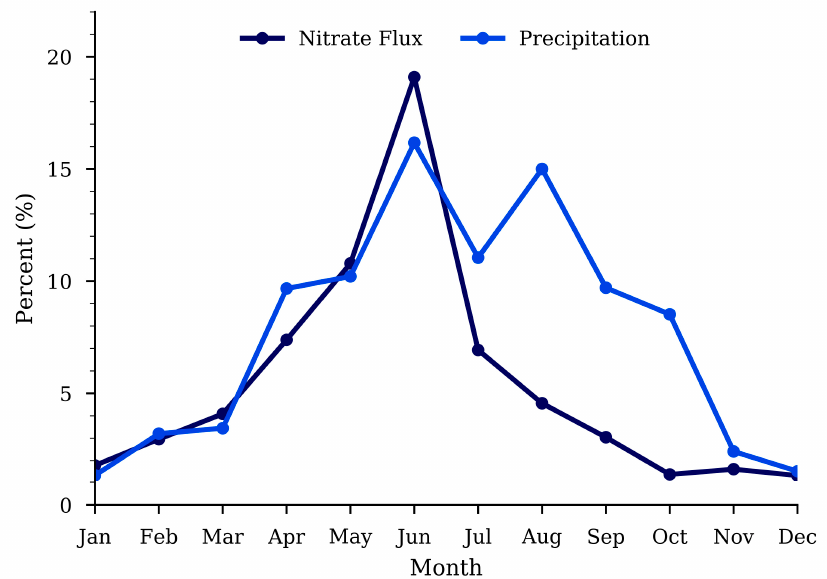
Figure 8. Median percentage contributions from 2000 to 2014 of each month to the annual value for nitrate flux (dark blue) and precipitation (light blue).